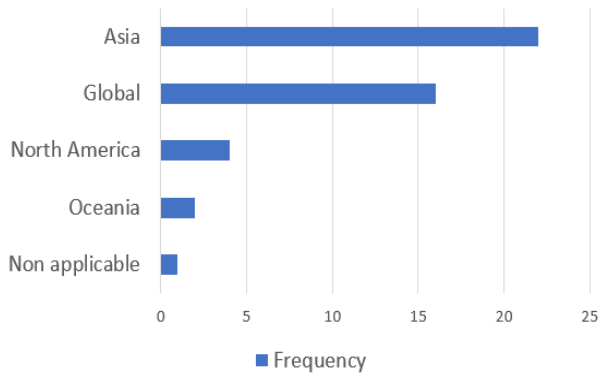
Figure 1. Continental coverage of studies.